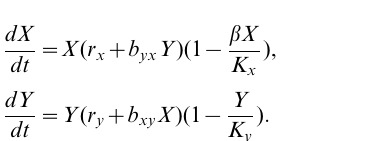
Figure 3. Initial population densities influence whether the cross-feeding will be favoured. For both simulations of model (1) and (2) =0.09, b xy = b yx =0.01, K =10000 and c y ~ c x ~ c x r y =0.11, r x =0.088, r x c feeding is not favoured for initial conditions e 1 = e 2 =0.001.